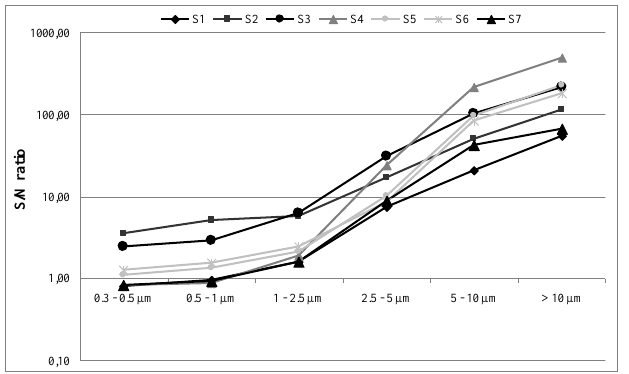
, PM , PM , PM , 0.5 0.5–1 1–2.5 2.5–5